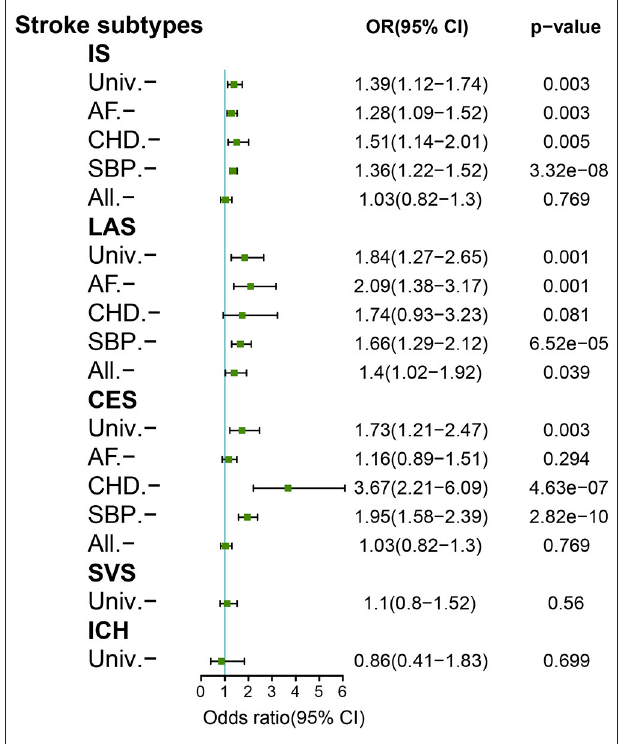
FIGURE 2 | Mendelian randomization analyses of genetically predicted HF with stroke subtypes. Adjustment for atrial fibrillation (AF), coronary heart disease (CHD), and systolic blood pressure (SBP). All, combined adjustment for AF/CHD/SBP; IS, ischemic stroke; CES, cardioembolic stroke; ICH, intracerebral hemorrhage; LAS, large-artery stroke; SVS, small-vessel stroke; Univ,